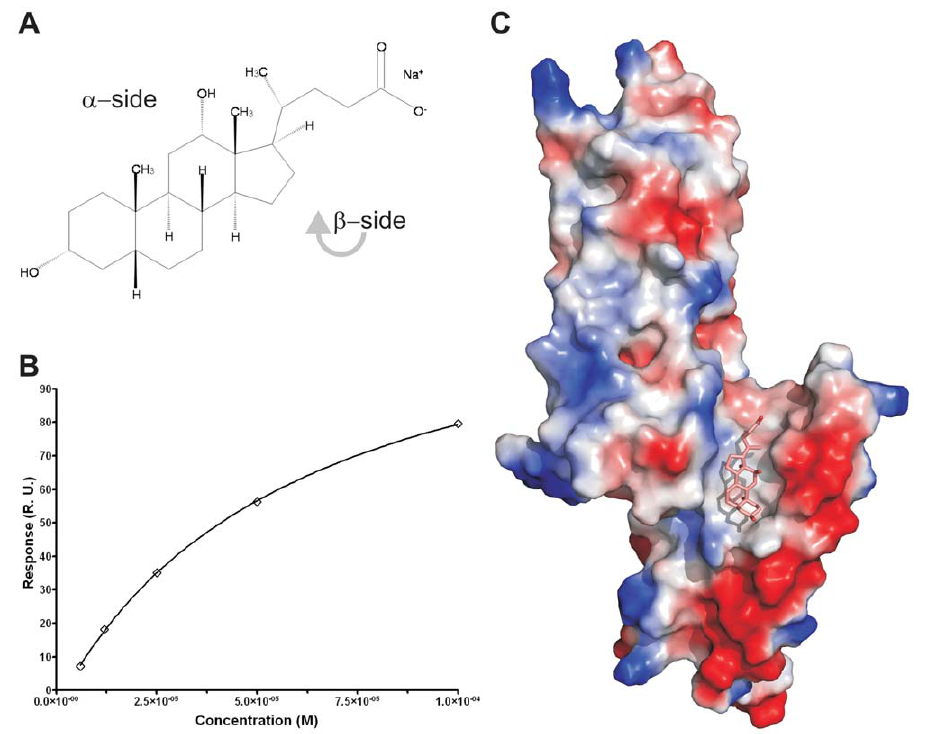
Figure 6. Binding assay and cocrystal structure of PrgI-SipD D D1 with deoxycholate. (A) Chemical formula of sodium deoxycholate, emphasizing the hydrophilic a - and the hydrophobic b -side of the molecule. (B) Binding curve of deoxycholate to PrgI-SipD D D1 : plot of the equilibrium binding response versus the concentration of deoxycholate. The solid line represents the fitting curve of the individual measurements. (C) Surface representation of the PrgI-SipD D D1 fusion protein (chain B) coloured according the electrostatic potential (blue positive, red negative). Deoxycholate bound in the hydrophobic cleft of the PrgI-SipD D D1 complex through its b -side is highlighted as a stick model.